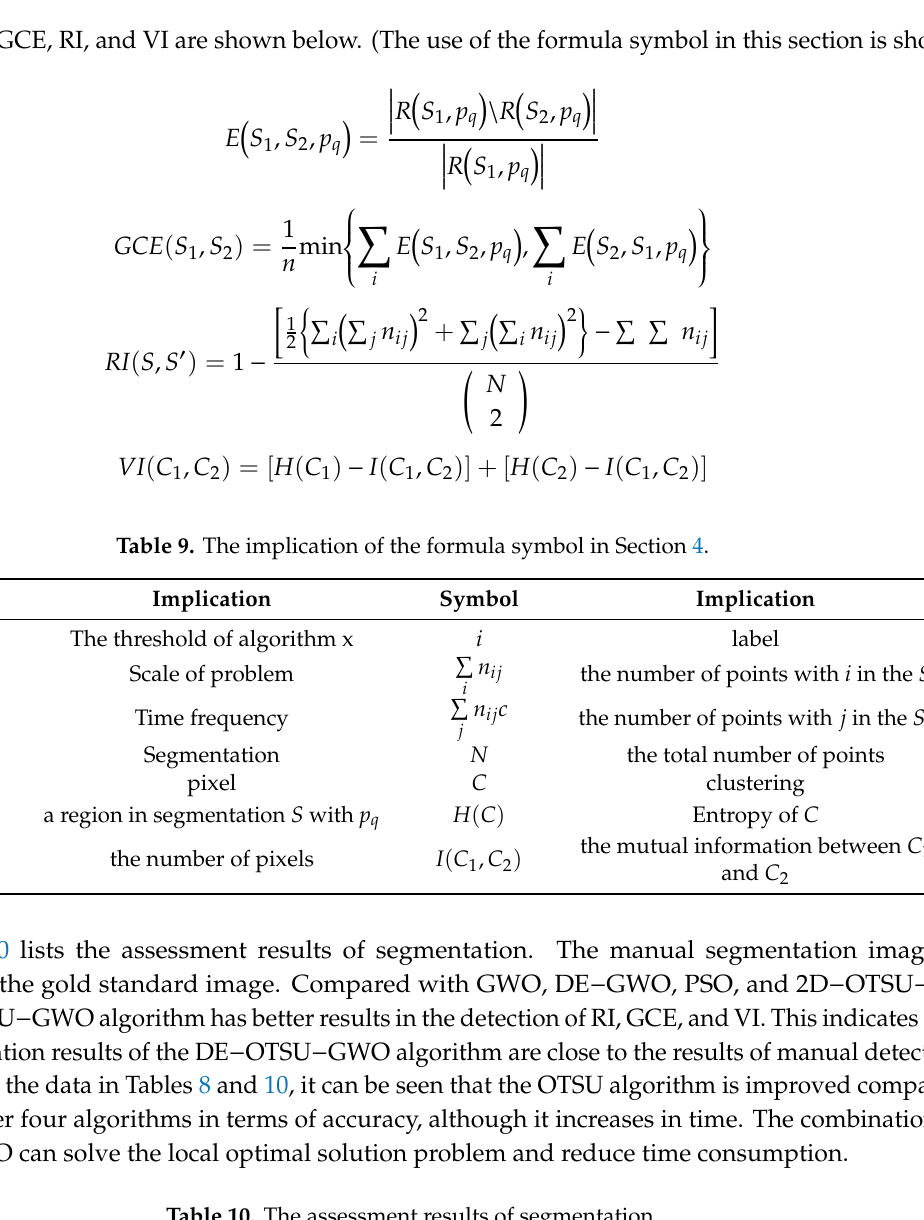
Table 10. The assessment results of